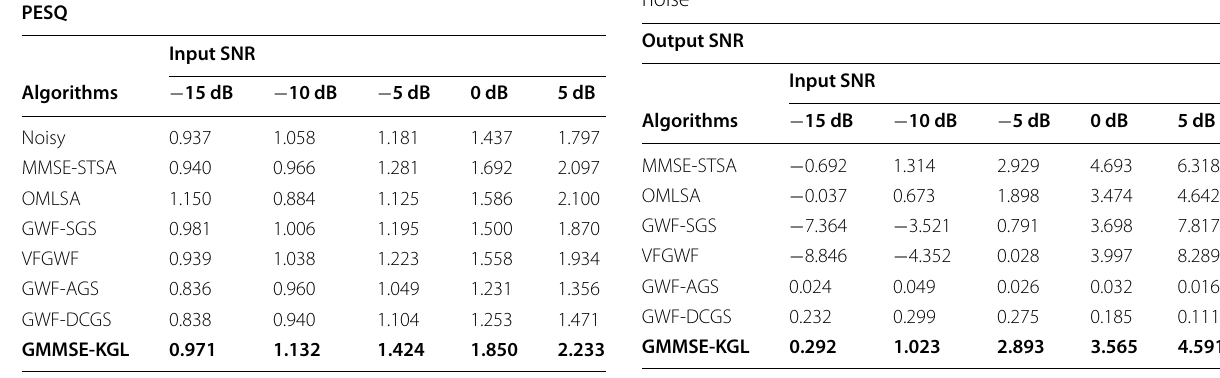
Table 9 The output SNR of different methods for Gaussian color noise